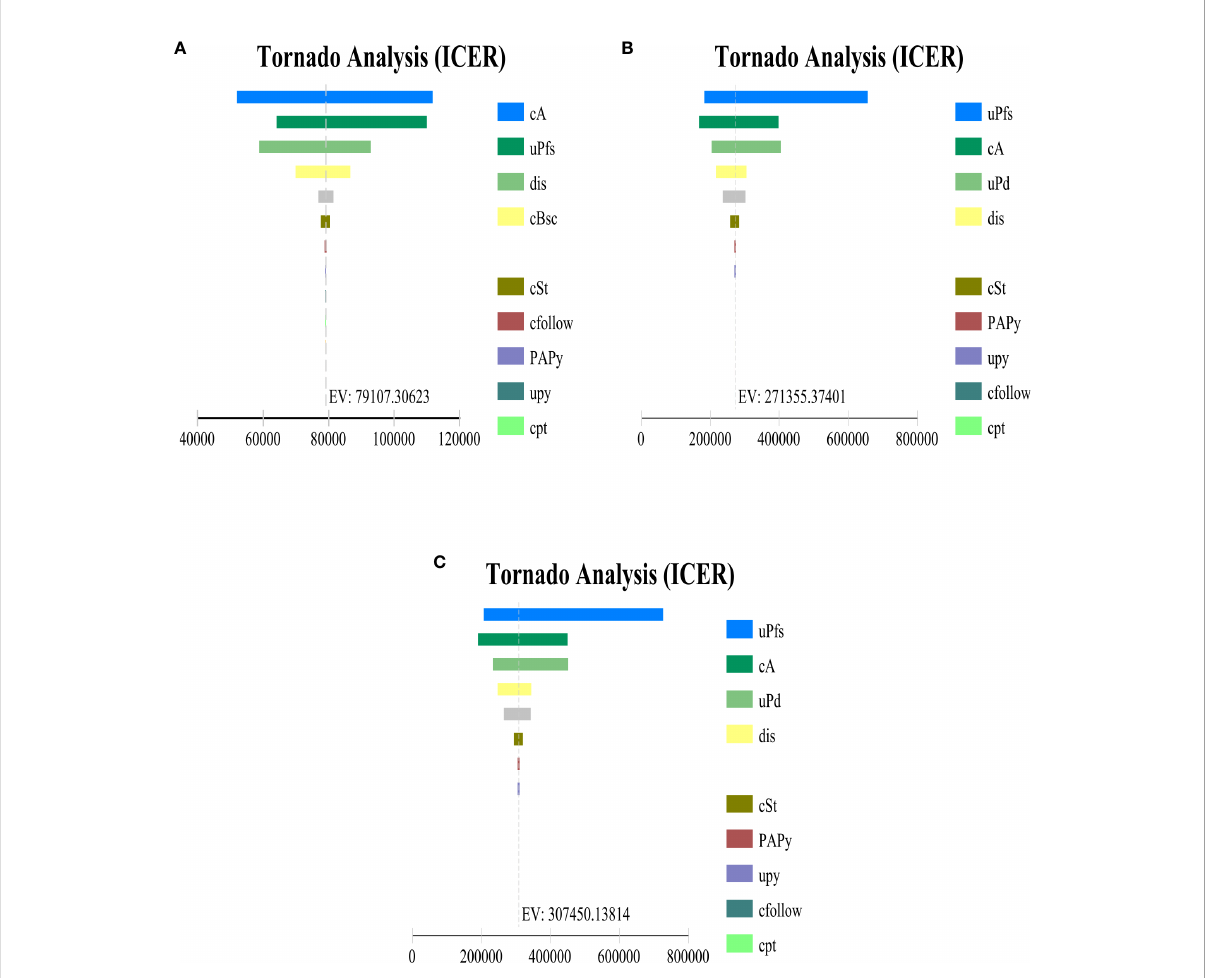
FIGURE 3 Tornado diagram indicating the most in fl uential parameter in (A) PD-L1 TC ≥ 1% stage II – IIIA group (SP263), (B) All stage II – IIIA, (C) Intention- to-treat group (stage IB – IIIA) when PAP is not applicable. cA, cost per cycle of atezolizumab treatment; uPfs, health utility of disease-free survival status; dis, discount rate; cBsc, cost per cycle of best supportive care; cSt, cost per cycle of subsequent therapy for progression status; cfollow, routine follow-up costs per cycle; PAPy, incidence of fever with atezolizumab; cpt, cost of palliative care in end-stage disease; cal, cost of alanine aminotransferase/aspartate aminotransferase elevation treatment; cpy, cost of Pyrexia treatment; PAAI, incidence of alanine aminotransferase elevation with atezolizumab; uPd, utility values for progressive disease